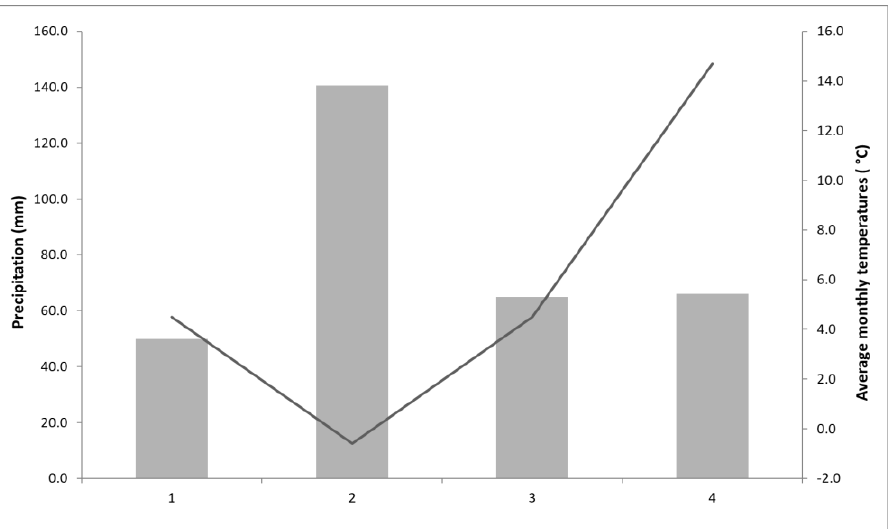
Figure 3. Climate diagram with data from the meteorological station ‘Šibice’ for the period of January (1) to April (4) (Croatian Meteorological and Hydrological Service, 2019). Columns represent precipitation (mm), while the line, the average monthly temperatures (°C).